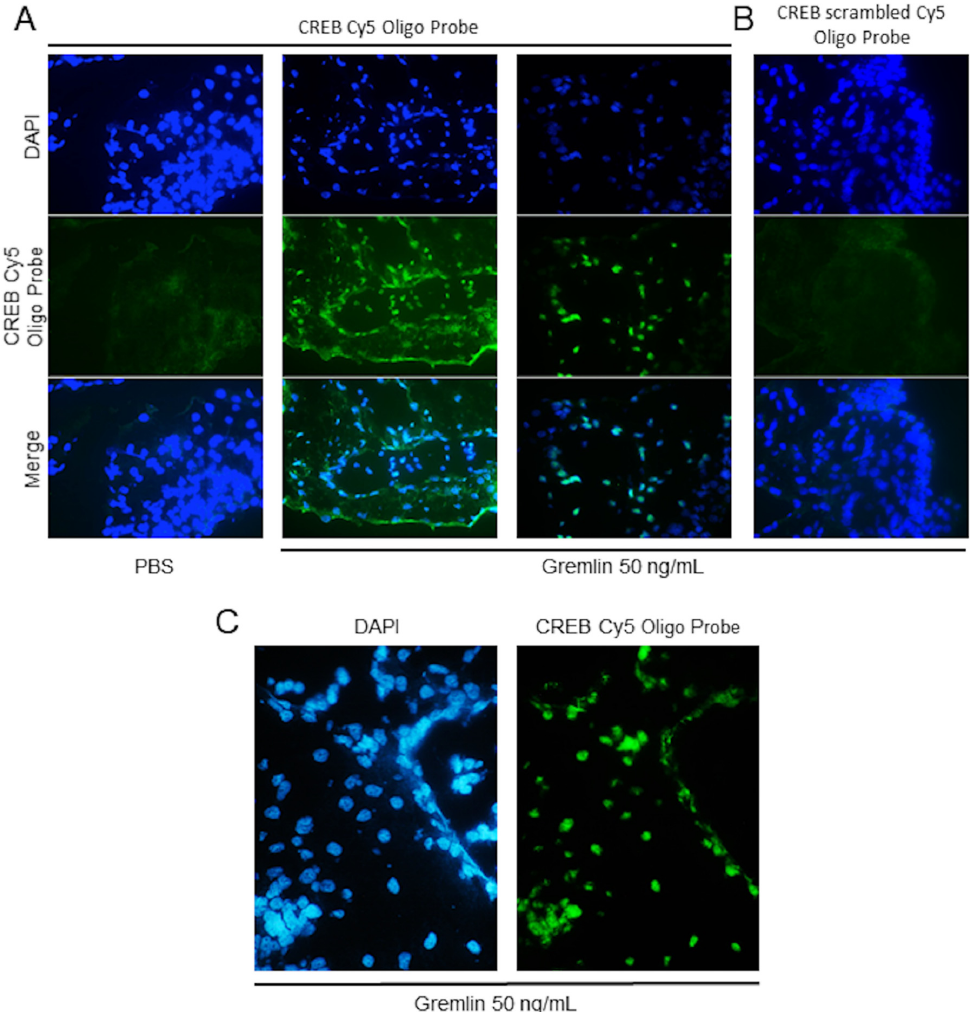
Figure 3. In situ DNA / CREB interaction in CAM sections. ( A ) Control and gremlin-stimulated CAM sections (5 µ m) were permeabilized and incubated with Cy5-labeled palindromic CREB binding oligo-probes. Nuclei were counterstained with DAPI (magnification 20×). ( B ) Gremlin-stimulated CAM sections (5 μ m) were permeabilized and incubated with Cy5- scrambled oligo-probes. ( C ) Magnification (40×) of gremlin-stimulated CAM sections (5 μ m).